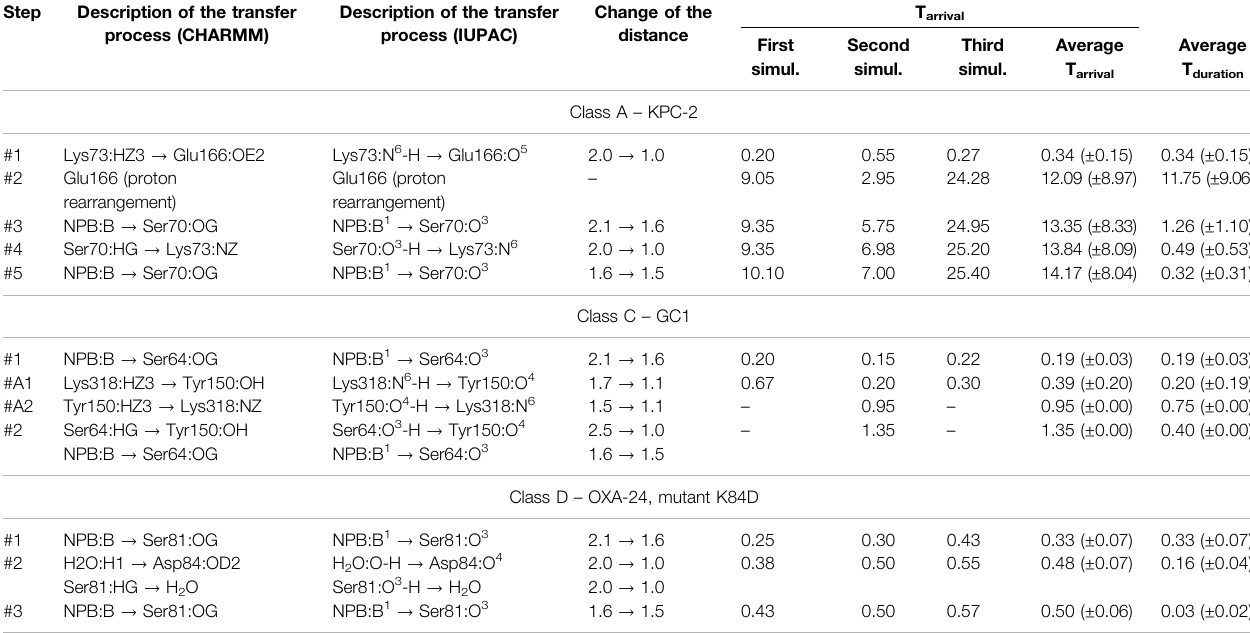
TABLE 1 | Approximate time-periods characterizing the covalentdocking process between 3NPBA and the members of the A, C, and D β -lactamases classes. 3-NPBA for simplicity is denoted as NPB. T arrival is the time to reach a given state on the reaction path, calculated from the beginning of the process. T duration is the average time to reach the nextstate, calculated from the previous one. All times, alongwiththeir standard deviations inparentheses,are given in ps. The atomic names follow the CHARMM force fi eldnomenclatureaswellastheIUPACnomenclature,andshowwhichatomhasmovedtowardswhichatominanothermolecularfragment.Thedistancesdescribing thechangesingeometryaregiveninÅ.Graphicalrepresentationsofthereactionstepsareshownin Figures4 , 6 .InclassC,stage#A2wasobservedonlyinthesecond simulation,reversingstep#A1and leadingback tothestructure asinstep#1.Thesimulations inclassCwhichwerestabilizedat stage#A1resultedinblocking step#2. Description of the transfer Change of the T arrival process (IUPAC) distance First Second Third Average simul. simul. simul. T